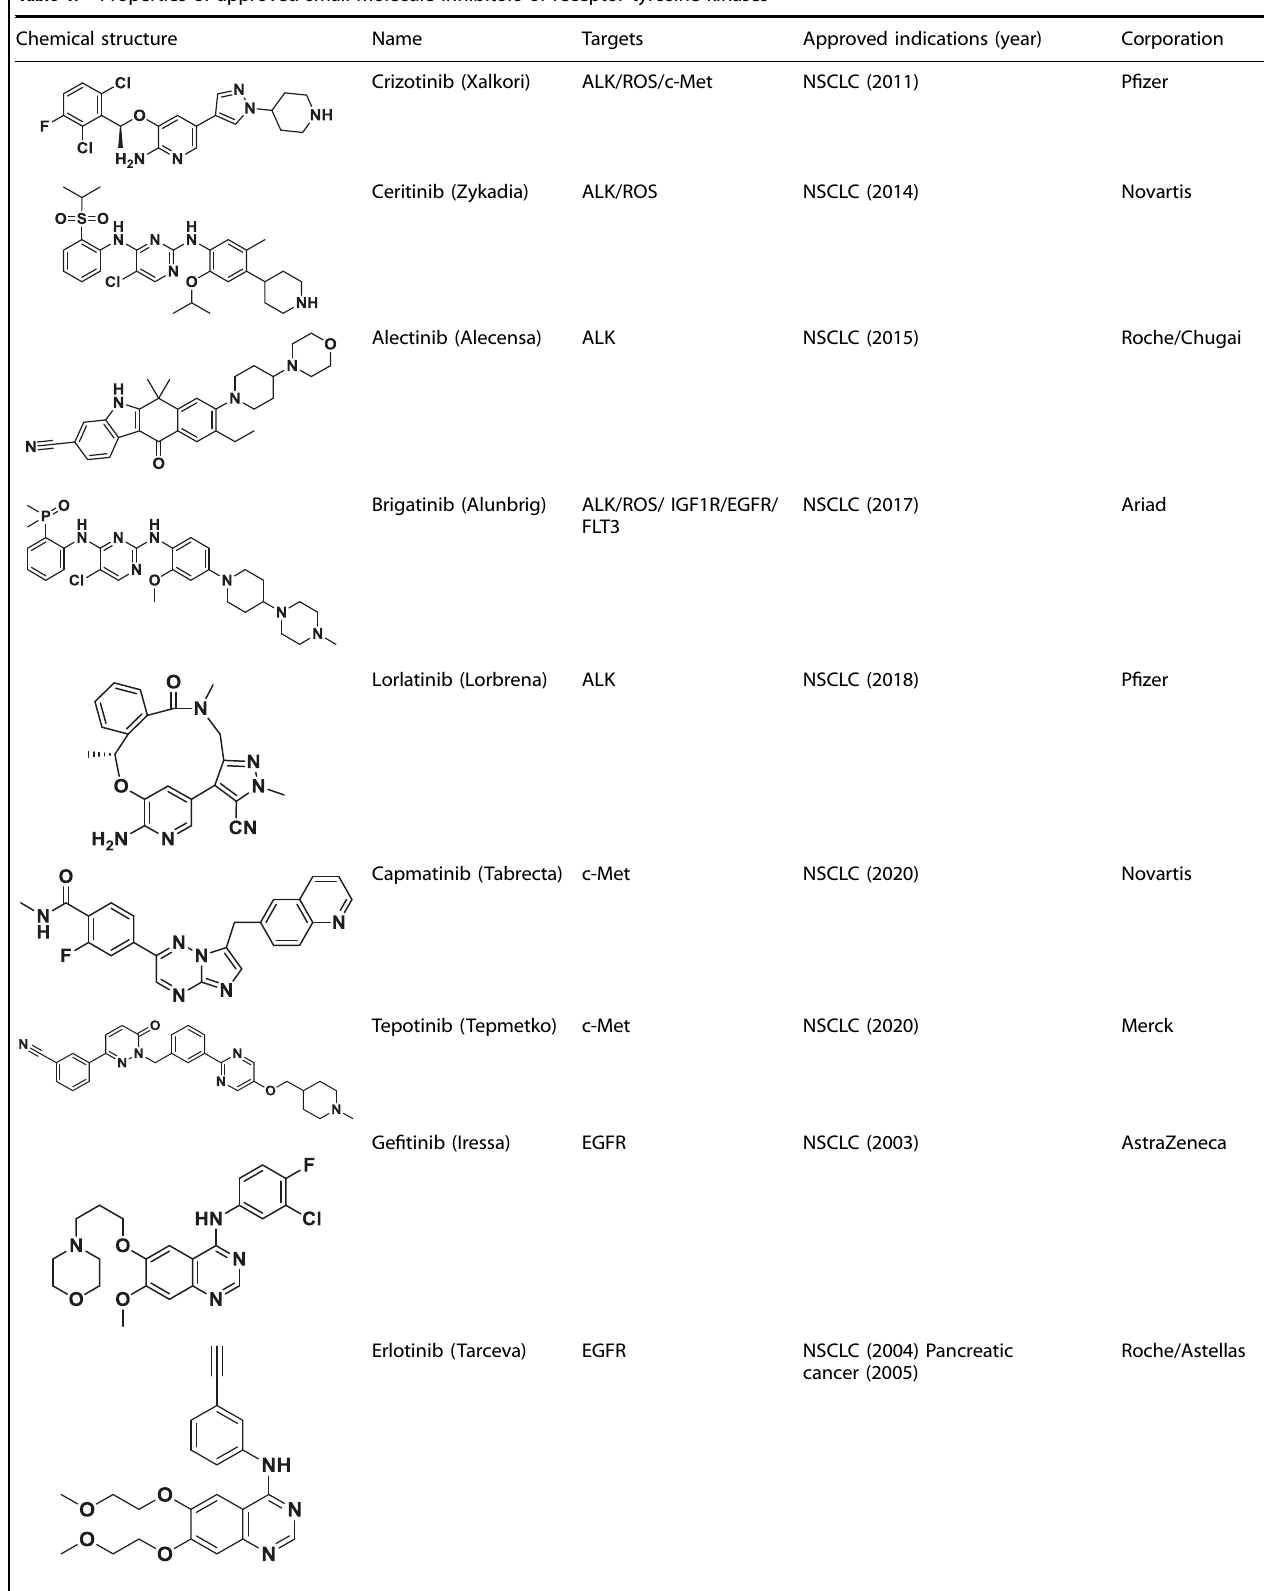
Table 1. Properties of approved small-molecule inhibitors of receptor tyrosine